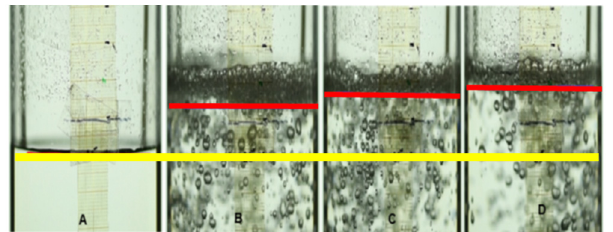
Figure 4. Determination of the change in liquid level (( A ) Initial level (yellow), ( B ) Lower reference during bubbling (red), ( C ) Mean reference during bubbling (red), ( D ) Upper reference during bubbling (red)) at u G = 5.2 × 10 − 3 ms − 1 .